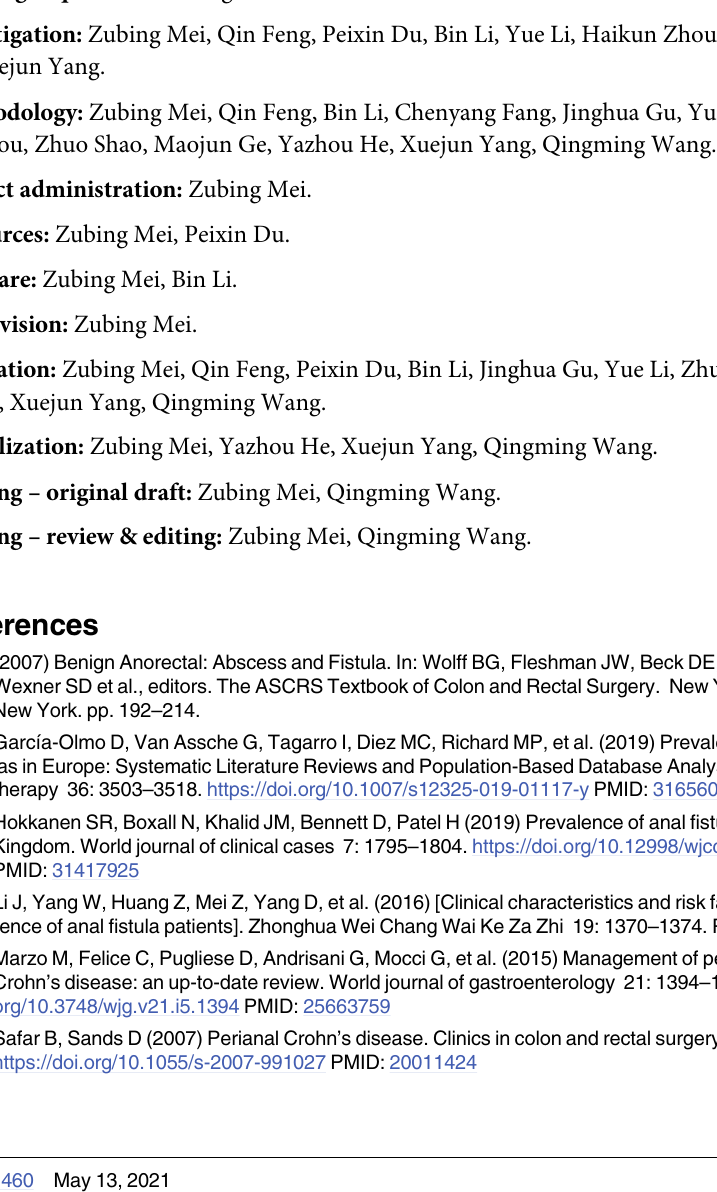
S2 Table. Search strategy for